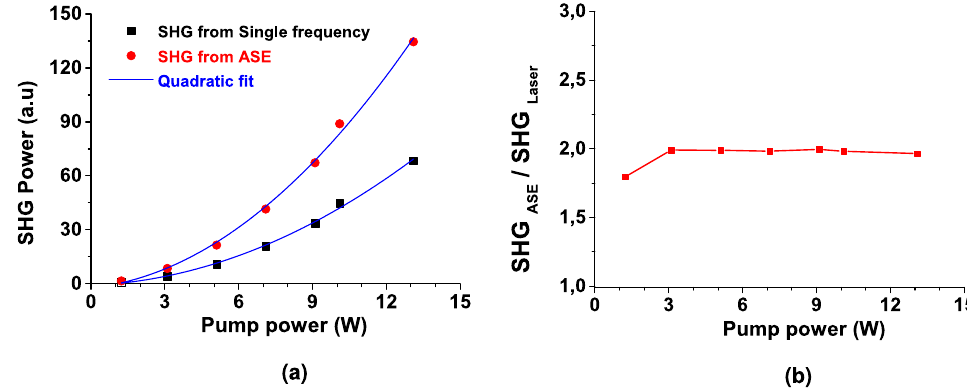
Figure 7. SHG of the pulsed partially coherent sources. ( a ) Black symbols: high coherence pulses. Red symbols: ASE pulses. Blue lines: quadratic fit. ( b ) SHG ratio between the high and low coherence